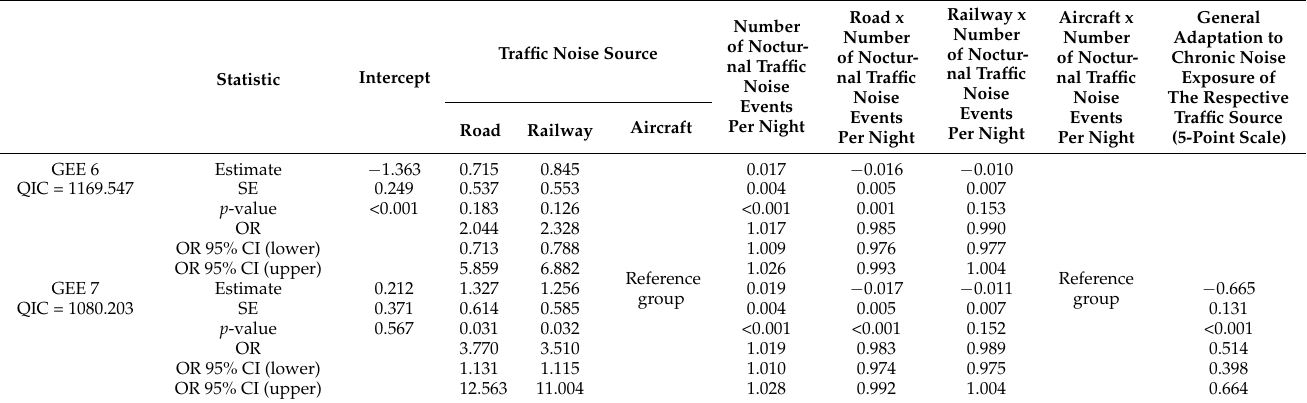
Table 4. Pooled random effects logistic regression calculated stepwise by Generalized Estimating Equation with regard to the effect of the number of nocturnal road traffic, railway, and aircraft noise events on annoyance: intermediate model GEE 6 and final model GEE